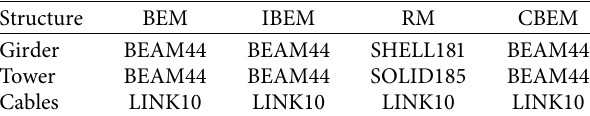
Table 2: Modelling